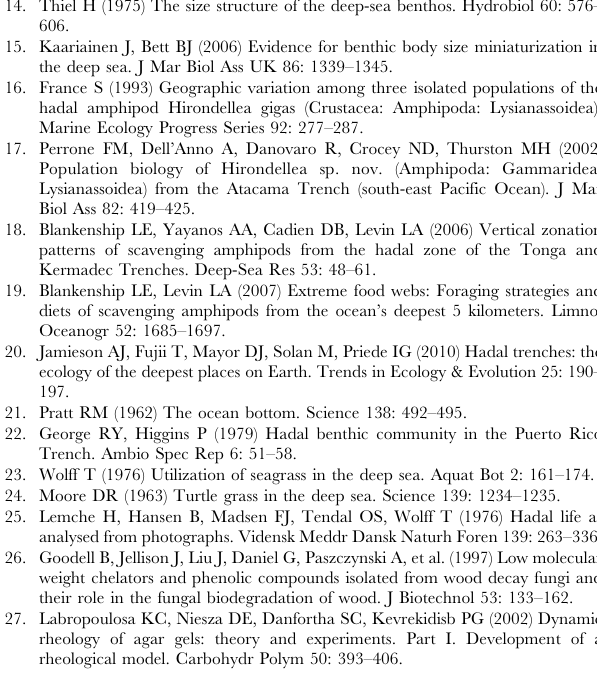
Figure S5 Production of glucose from a piece of plain paper by HGcel. HGcel was spotted on a piece of plain paper (arrow indicated, left). Glucose was detected as pink colored spot by Glucose CII kit after 15 h incubation at room temperature (arrow indicated, right). (TIF) Figure S6 PCR assay for bacterial or archeal 16S ribosomal DNA in H. gigas . Mitochondrial cytochrome oxidase subunit I (CYO) DNA was used as a positive control for PCR reaction, and Escherichia coli HB101 and Halobacterium salinarium ATCC29341 DNAs were used as positive controls for bacteria and archea. M: DNA marker. (TIF) Movie S1 The capture of H. gigas by net style bait trap at the deepest point at 10,898 m on 20 May 1998. We baited the trap on the previous day. H. gigas can be seen gathering around the bait trap. The remotely operated submersible ‘Kaiko’ collected the trap.